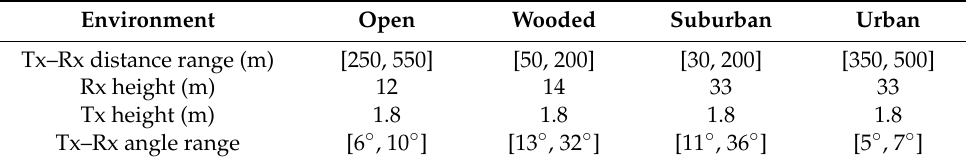
Figure 4. Pan–tilt element at the mobile end. Table 2. Measurement Scenarios.